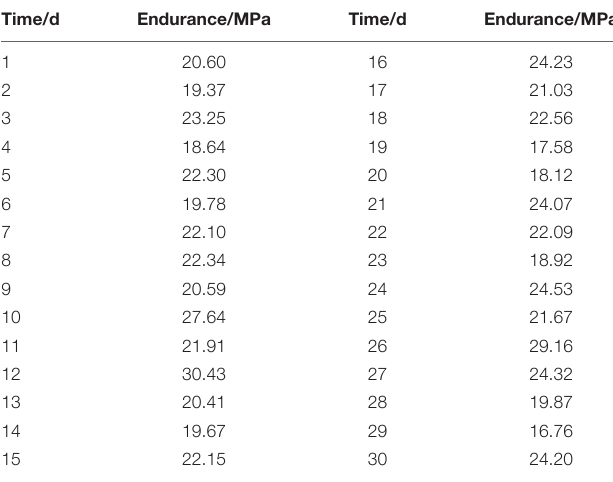
TABLE 1 | Real-time monitoring data.